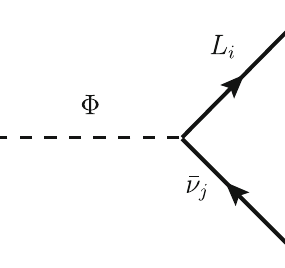
Fig. 3 Leptonic CP asymmetry generated in (cid:11) → L ¯ ν decay at ) , where the left and the O ( Y 2 ν Y 2 (cid:3) right diagram represent the tree-level and the one-loop contribution,